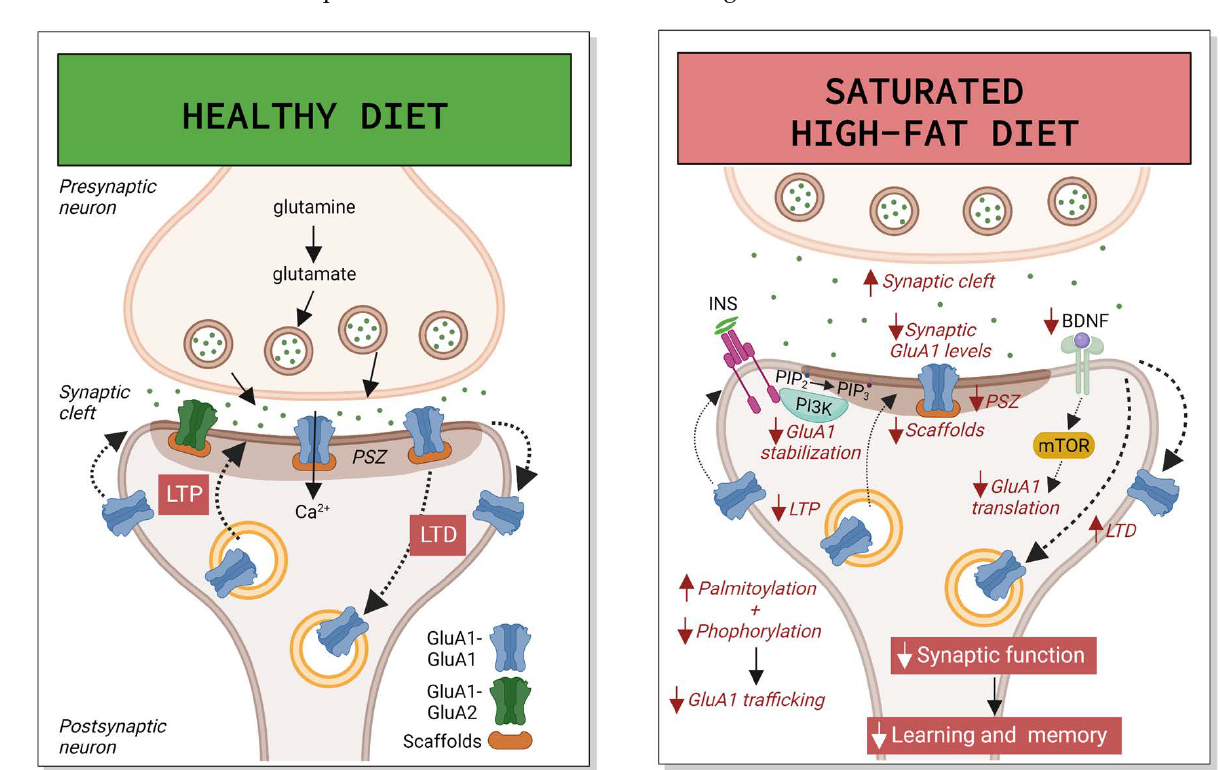
Figure 1. Mixed and saturated high-fat diet (HFD) deregulation of AMPARs in the hippocampus (HPC). In normal conditions, glutamate release induces activation of ionotropic α -amino-3-hydroxy- 5-methyl-4-isoxazolepropionic acid receptors (AMPARs), both GluA1-GluA1 homomers and GluA1- GluA2 heteromers, which mediate fast excitatory synaptic transmission. Under neuroplasticity paradigms like long-term potentiation (LTP) and long-term depression (LTD), AMPAR levels in the post-synaptic zone (PSZ) increase or decrease by exocytosis or endocytosis, respectively, or through changes in their lateral diffusion, mainly controlled by phosphorylation and dephosphorylation. An intake of saturated HFD decreases LTP, enhances LTD, and reduces total GluA2 and synaptic GluA1 levels. This decrease in GluA1 may be a consequence of increased palmytoilation mediated by palmitic acid (PA) and insulin (INS) and decreased phosphorylation, and by a decline in the levels of auxiliary and scaffold proteins. All these processes may impair trafficking of GluA1 towards the plasma membrane (PM). Moreover, PA-induced phosphorylation of PI(4,5)P 2 (also called PIP 2 ) by phosphoinositide 3-kinase (PI3K), a protein kinase activated by INS, may compromise surface GluA1 stabilization, and decayed GluA1 synthesis, mediated by brain-derived neurotrophic factor (BDNF) through the mammalian target of rapamycin (mTOR), may downregulate both total and synaptic levels. Altogether, the outcome is synaptic dysfunction and learning and memory impairment. Other figure abbreviations are as follows: Ca 2+ : calcium ion; PIP 2 : phosphatidylinositol (4,5)-bisphosphate; PIP 3 : phosphatidylinositol (3,4,5)-trisphosphate. Image created with